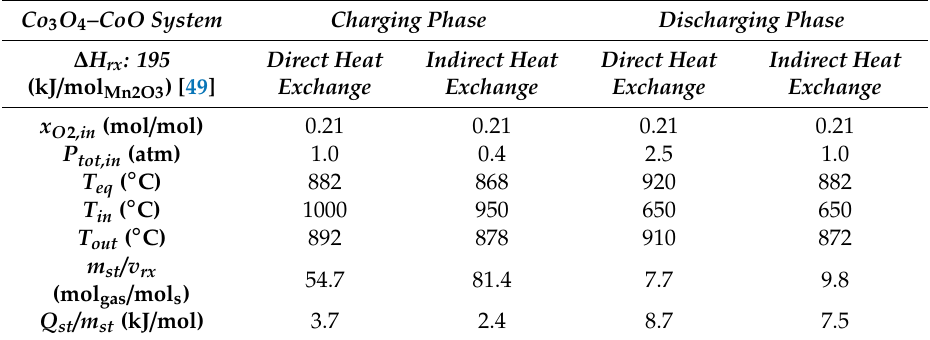
Table 5. TCS operating conditions for the cobalt oxide system (open cycle and adiabatic